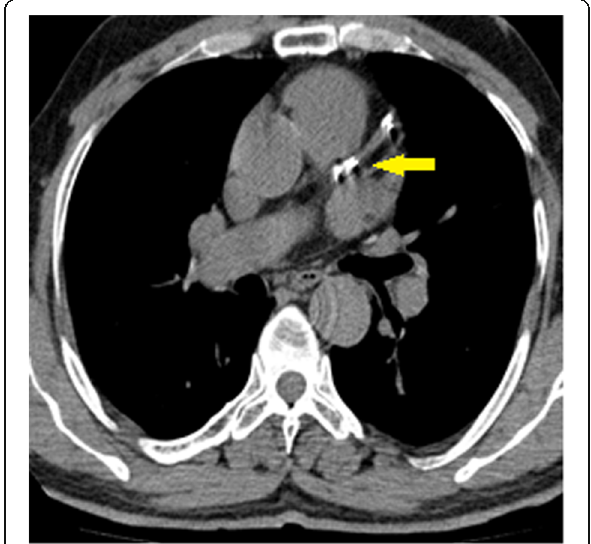
Fig. 1 Non-contrast ECG-gated MSCT examination of the coronary artery for detection and quantification of the coronary calcifications (coronary calcium score) showing calcified athermanous plaques at the proximal and mid LAD segment